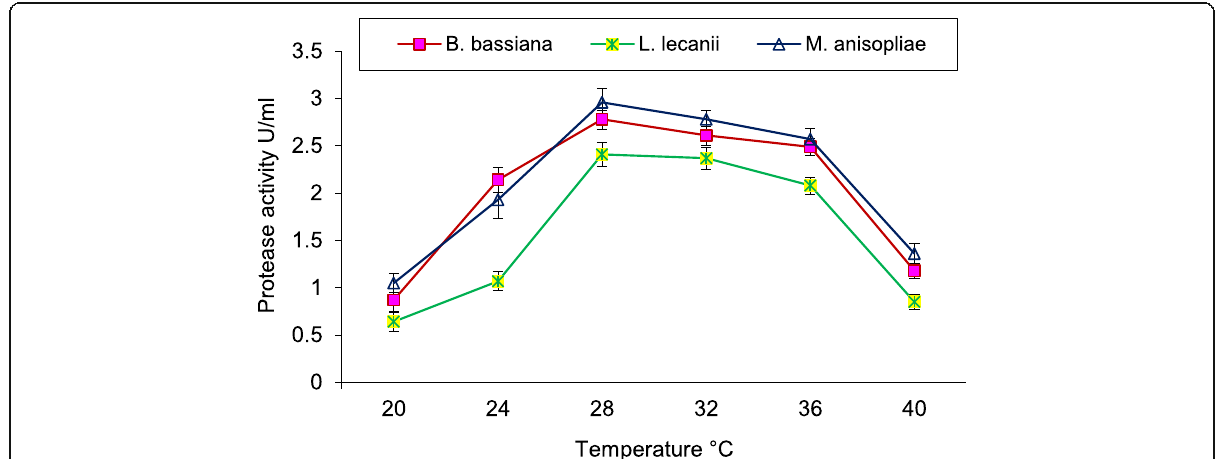
Fig. 4 Effect of temperature on protease activity of the EPF isolates of Beauveria bassiana , Lecanicillium lecanii , and Metarhizium anisopliae